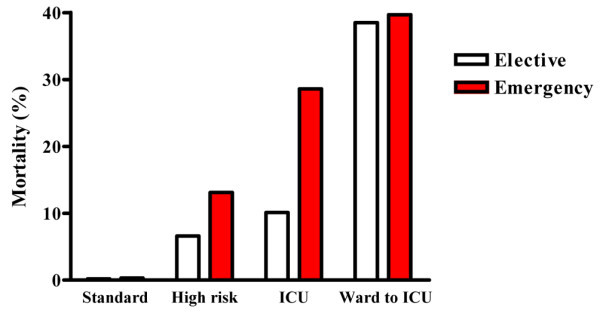
Mortality rates for general surgical patients identified from the CHKS and ICNARC databases. CHKS database: standard, all patients admitted to hospital for a general surgical procedure with an overall mortality rate of less than 5%; high risk, subpopulation of patients undergoing a procedure with an overall mortality rate of 5% or more. ICNARC database: ICU, general surgical patients admitted directly to the intensive care unit following surgery; ward to ICU, patients admitted to the intensive care unit following initial postoperative care on a standard ward.